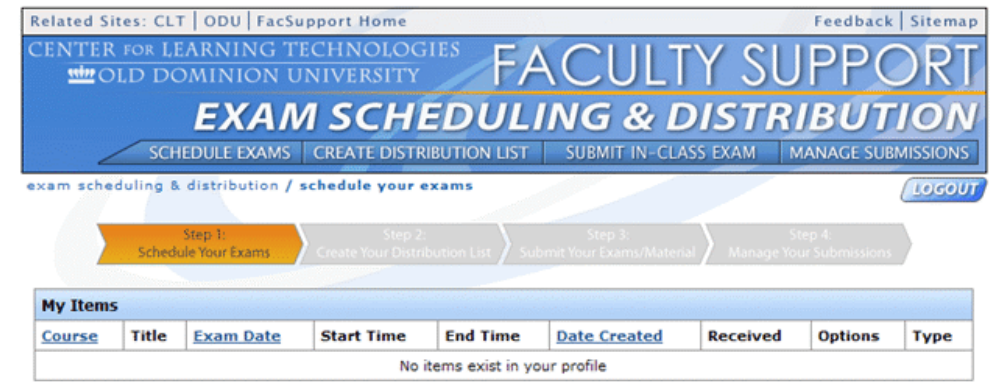
Figure 4. A Web-based exam distribution and scheduling process